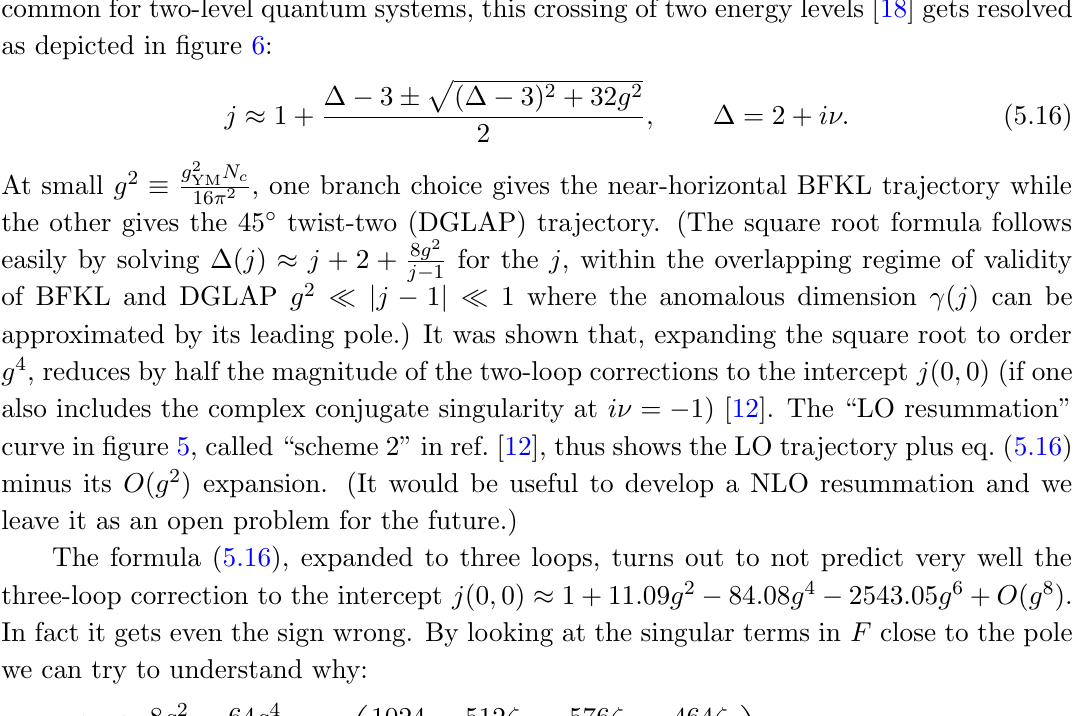
Figure 5 . The BFKL eigenvalue for m = 0 along the real (cid:23) axis at various orders for (cid:21) = g 2 6. Convergence near the maximum is visibly slower than away from it. The \resummation of leading-order" is de(cid:12)ned below eq.